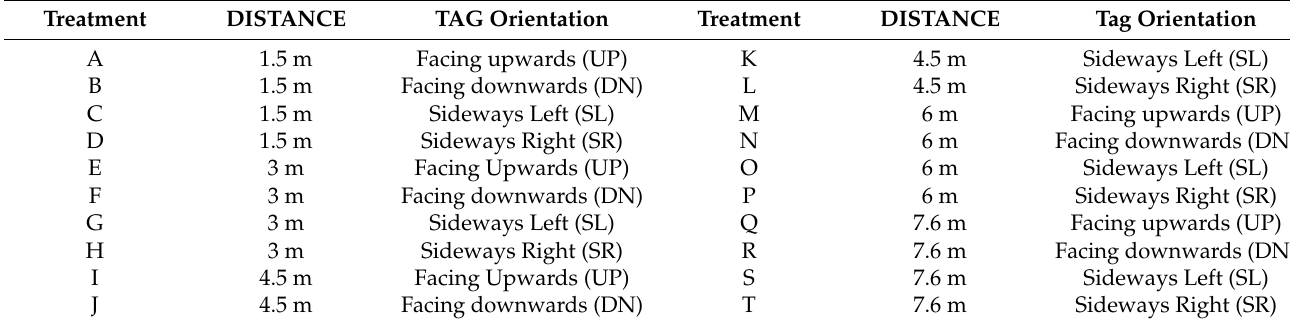
Table 3. The treatment combinations for laboratory experiment 2.6.2.